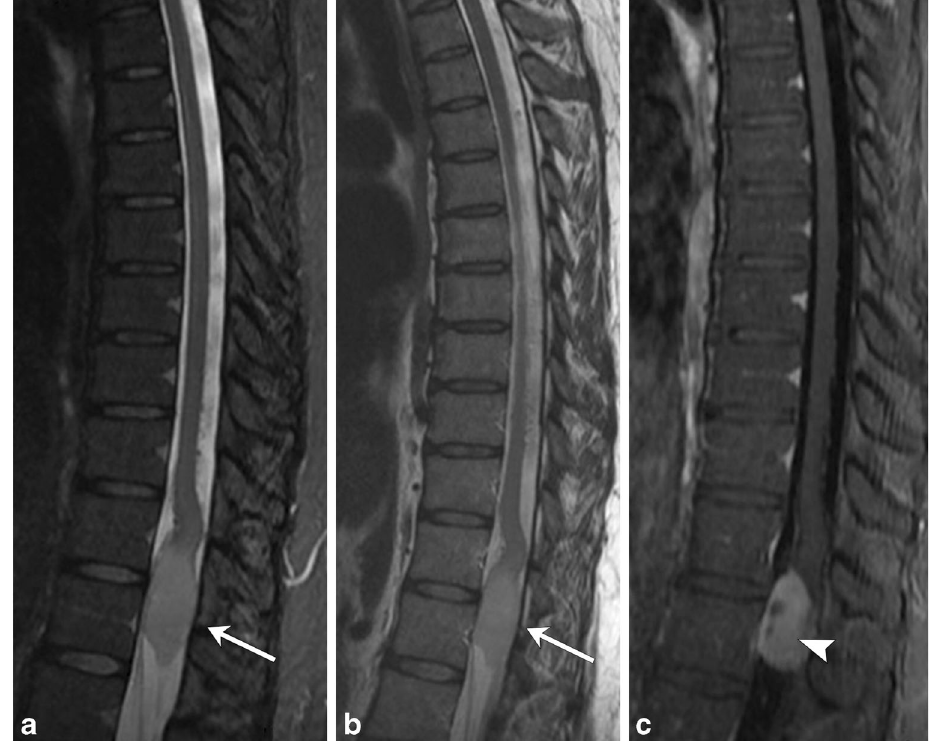
Fig. 17 Glioblastoma multiforme. A 46-year-old female with lumbar back pain and recent onset of urinary retention. There is an expansile lesion within the distal spinal cord with intermedi- ate T2 hyperintensity ( a , arrow) and non-uniform enhancement ( c , arrowhead)